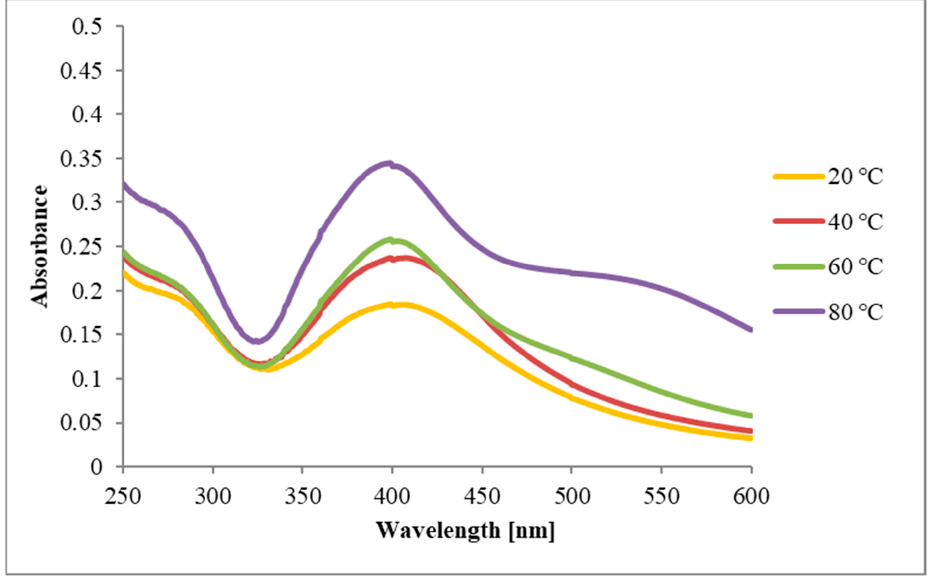
Figure 7. The influence of temperature (20 ℃ , 40 ℃ , 60 ℃ , and 80 ℃ ) on AgNPs-H 2 O formation.